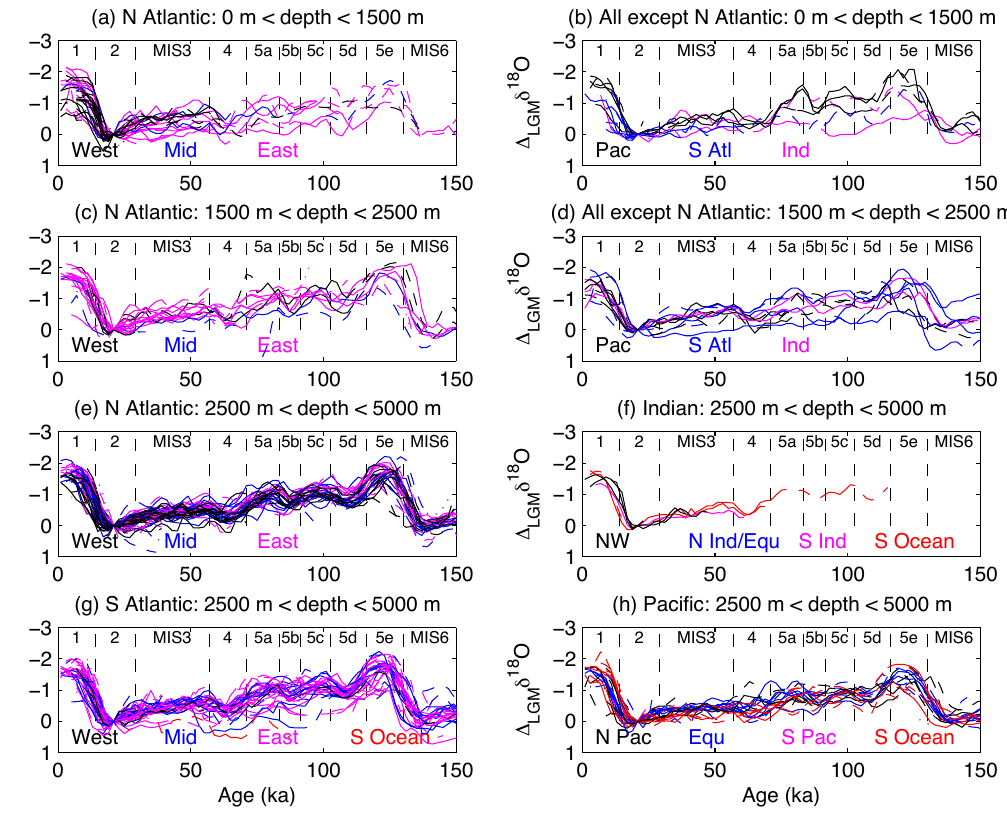
Fig. 3. Benthic δ 18 O, as an anomaly relative to the 21ka value, time-series by region. Timeseries are smoothed by the method described in Sect. 3.1.1, and data with a temporal resolution poorer than 6ka removed, but no species corrections or error estimates are made. In a small number of records, the δ 18 O maxima (note the reversed δ 18 O axis) differ from 18, 62, 87, 108, and 137ka; these occur either where there is disagreement regarding the timing of the δ 18 O maxima in records from different species from the same core, or where not all δ 18 O maxima could be identified with confidence. Marine Isotope Stages are indicated in each